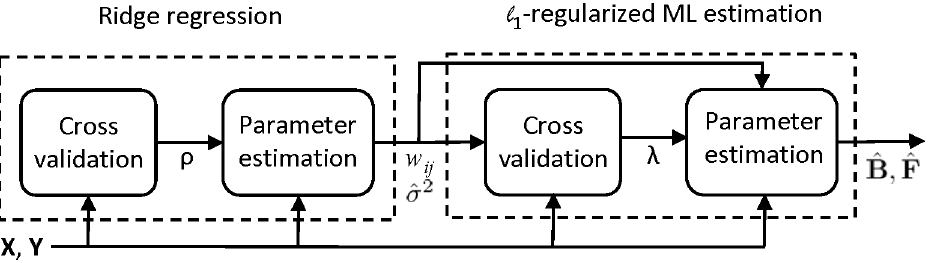
Figure 1. Block diagram of the sparsity-aware maximum likelihood (SML) algorithm. The first and third blocks perform cross-validation to select optimal parameters r and l to be used in (3) and (4), respectively. The second block produces weights f w ij g and error-variance estimate ^ ss 2 after solving (4). Finally, the fourth block takes data X and Y together with l , f w ij g and ^ ss 2 and solves (3) to yield ^ BB , which represents the SML estimator for B in (1) revealing the genetic-interaction network. A more detailed description of the SML algorithm is given in Algorithm 1 in the Methods section.